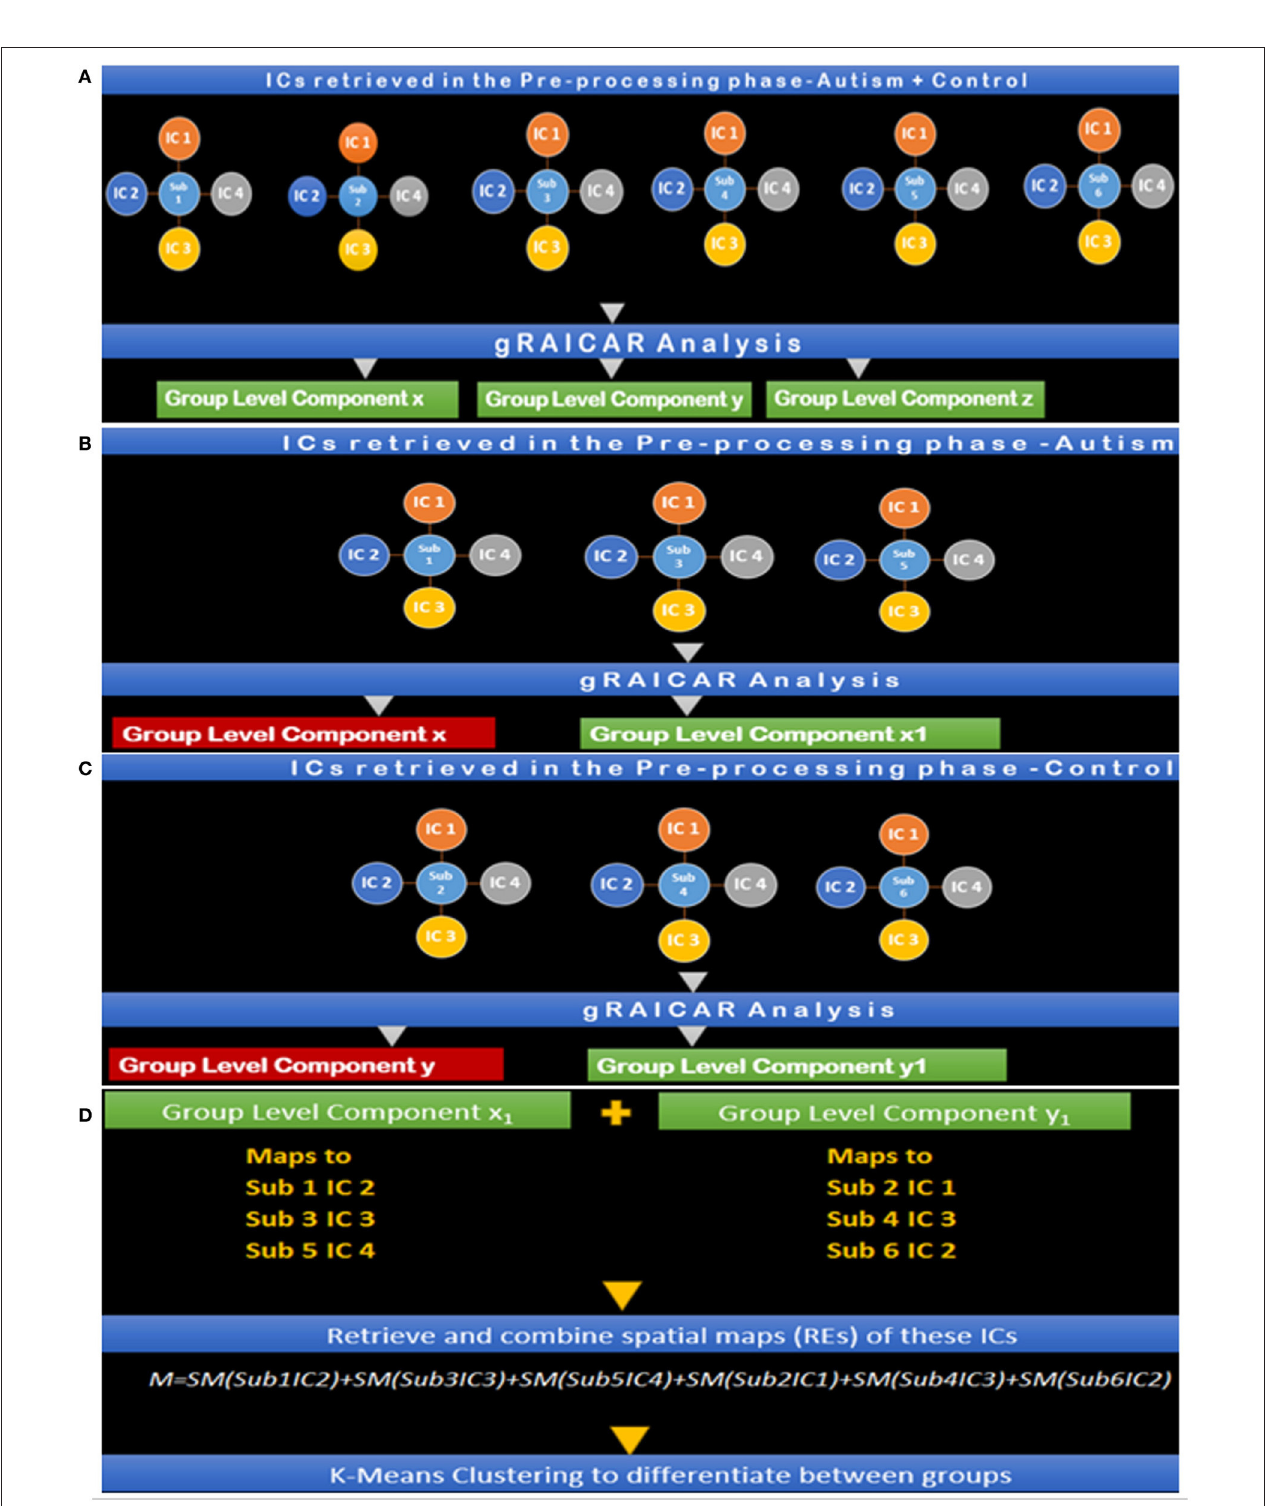
FIGURE 7 | (A) Step I: gRAICAR Analysis on Combined (Autism + Control) Group producing group level components x, y, and z. (B) Step II: gRAICAR Analysis on Autism Group Only, producing group-level components, x and x 1 . x is discarded since it was produced in step I. (C) Step III: gRAICAR Analysis on Control Group Only, producing group-level components, y and y 1 . y is discarded since it was produced in step I. (D) Step IV: Group level components from Steps II and III were combined by retrieving spatial maps corresponding to ICs these group-level components represented for each subject within each group as shown in the figure. Group level components reproducible in the combined group also found in individual analysis (steps II and III) were excluded.